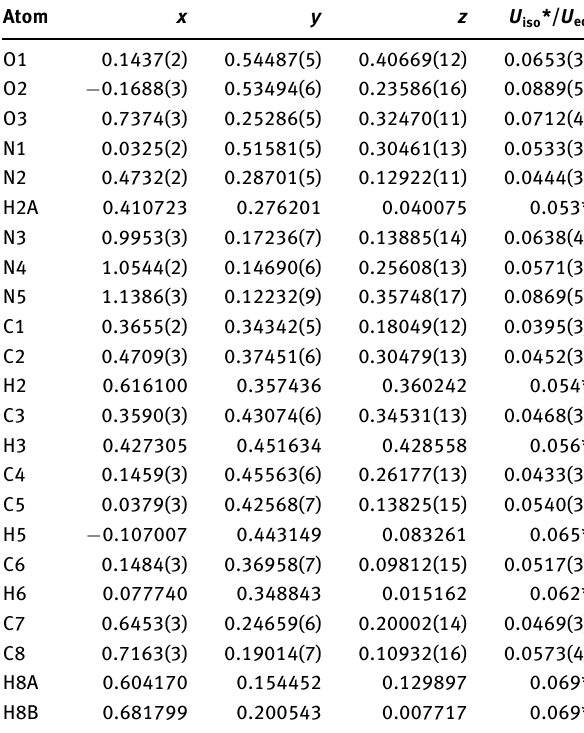
Table 2: Fractional atomic coordinates and isotropic or equivalent isotropic displacement parameters (Å 2